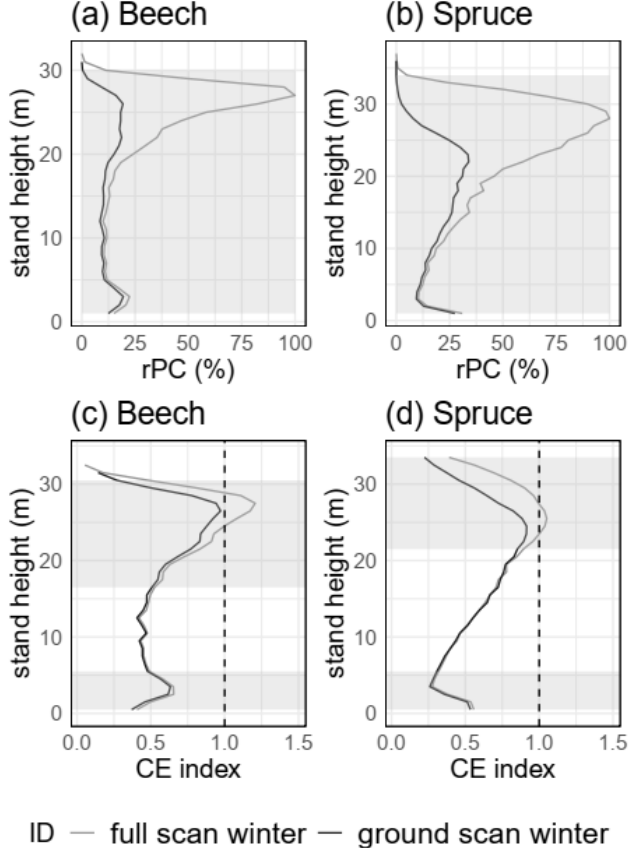
Figure 8. Methodical comparison between the ground scans and full scans conducted in winter for relative point counts (rPC) ( a , b ) and CE indices ( c , d ) over the height range. The black curve shows the counts for the ground scan, and the gray curve shows those for the full scan. The curves are based on six circular subplots, each with a radius of 5 m. Shaded in gray is the height range in which the scans differ significantly from each other. The resolution of the point clouds was 5 cm.